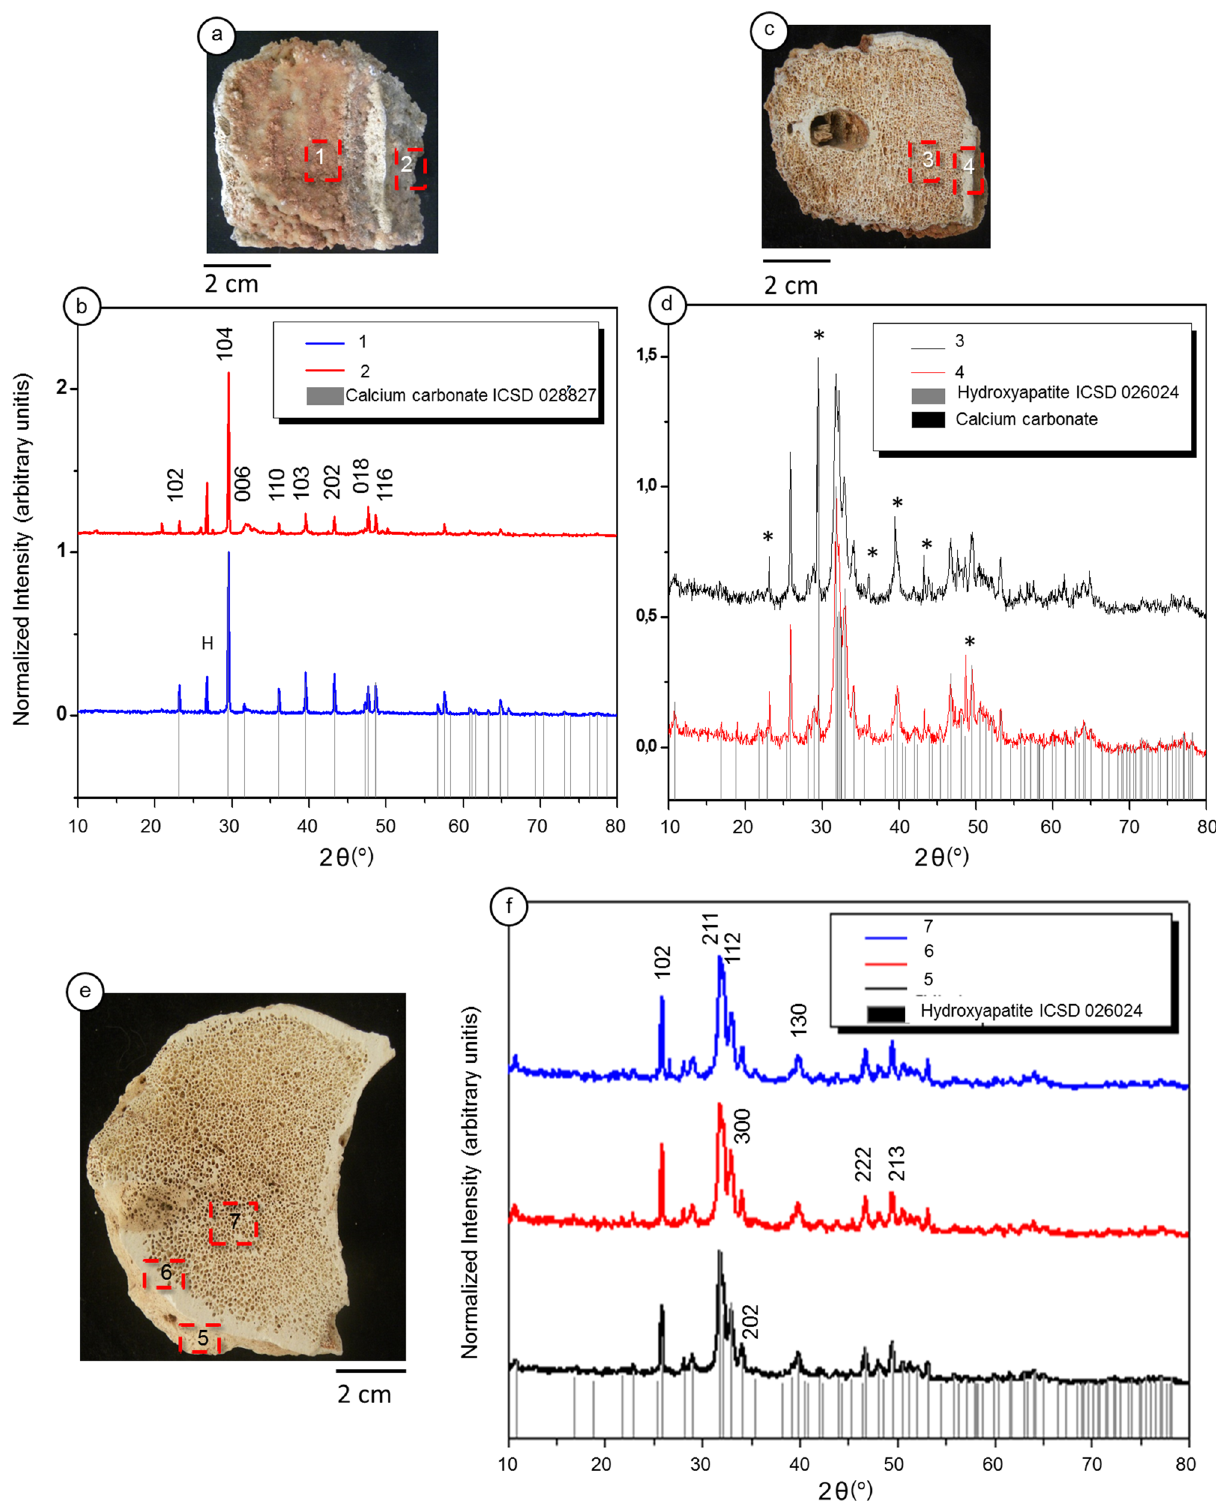
Figure 6. X-ray diffraction (XRD). ( a )—Image of the external surface of the LAPA/SBF-3-0017 sample. The red dashed boxes (areas 1 and 2) indicate the bone location where the data were collected, as represented in the diffractogram. ( b )—Diffractograms of the sample external face. ( c )—Image of the internal surface of the sample. The red dashed boxes show the locations of the data represented in the diffractogram, in which area 3 focuses on the cancellous bone and area 4 focuses on the cortical bone. ( d )—Diffractograms of the internal surface of the sample. ‘*’ indicates peaks for calcite. Reference standards for ICSD 026204 hydroxyapatite and calcium carbonate ICSD 028827. ( e )—Image of the LAPA/SBF-3-0081 sample. The red dashed boxes represent the location of the data represented in the diffractogram, in which area 5 focuses on the external surface, area 6 focuses on the cortical bone, and area 7 focuses on the cancellous bone. ( f )—Diffractograms of the internal and external surfaces of the LAPA/SBF-3-0081 sample. The numbers in the diffractograms represent the hkl plane. The diffractogram images were constructed by X-Pert HighScore software